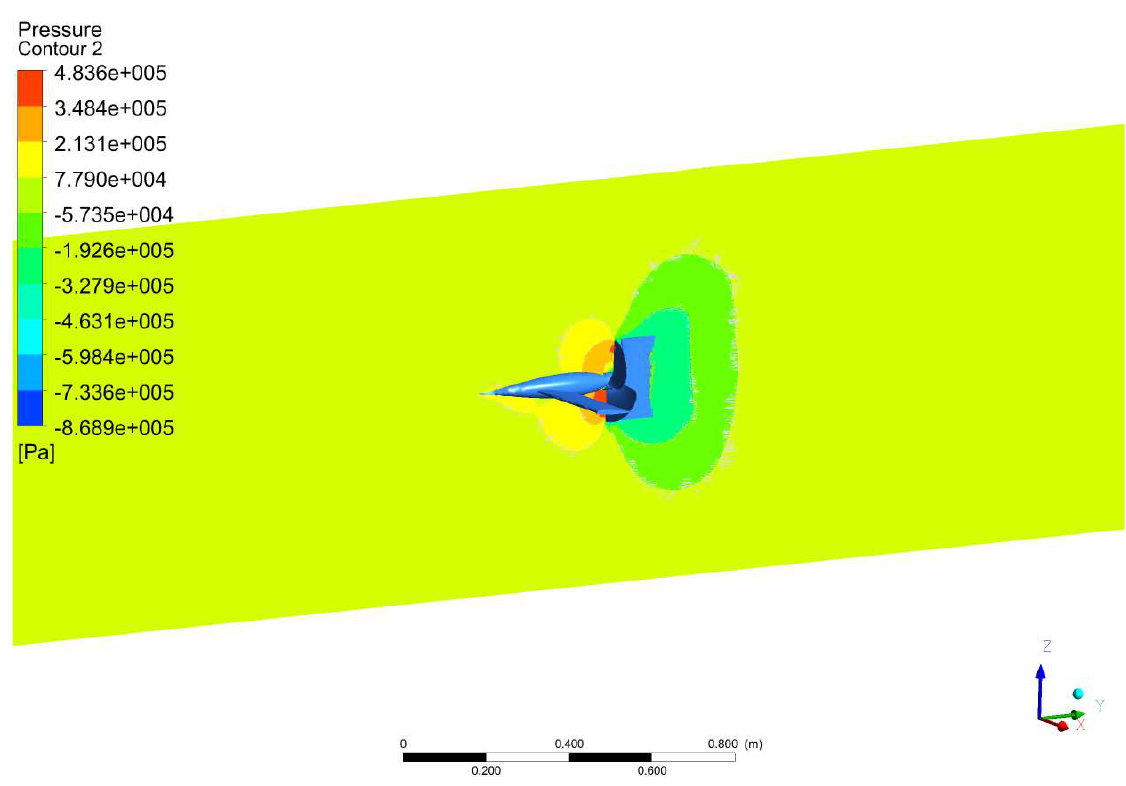
Figure 32. Variations of velocity over the US with rectangular wing.